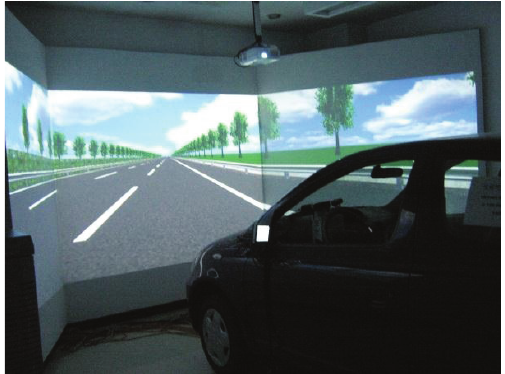
Figure 4: The AutoSim simulator system.